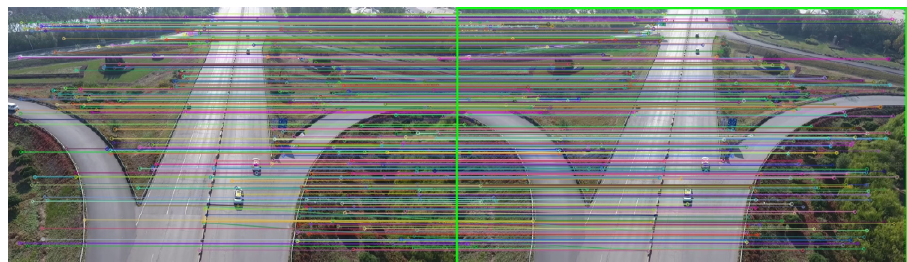
Figure 13. The matching map of two consecutive images. We used different colors to represent the corresponding matching points, and connected these points with different